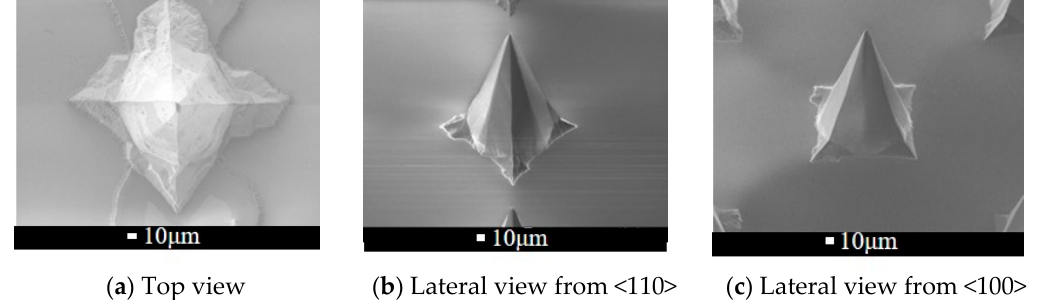
Table 2. Angles from different view.